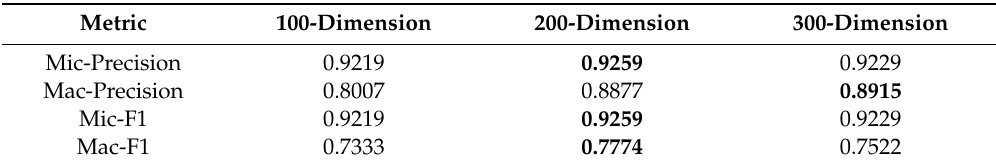
Table 6. Precision and F1 score in di ff erent dimension word embedding for 20 sliding window size.